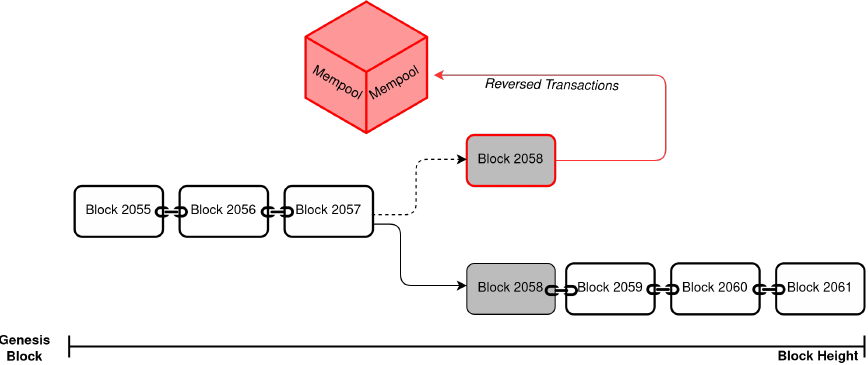
Figure 4. Example of 1 confirmation attack while a stale block triggers in the